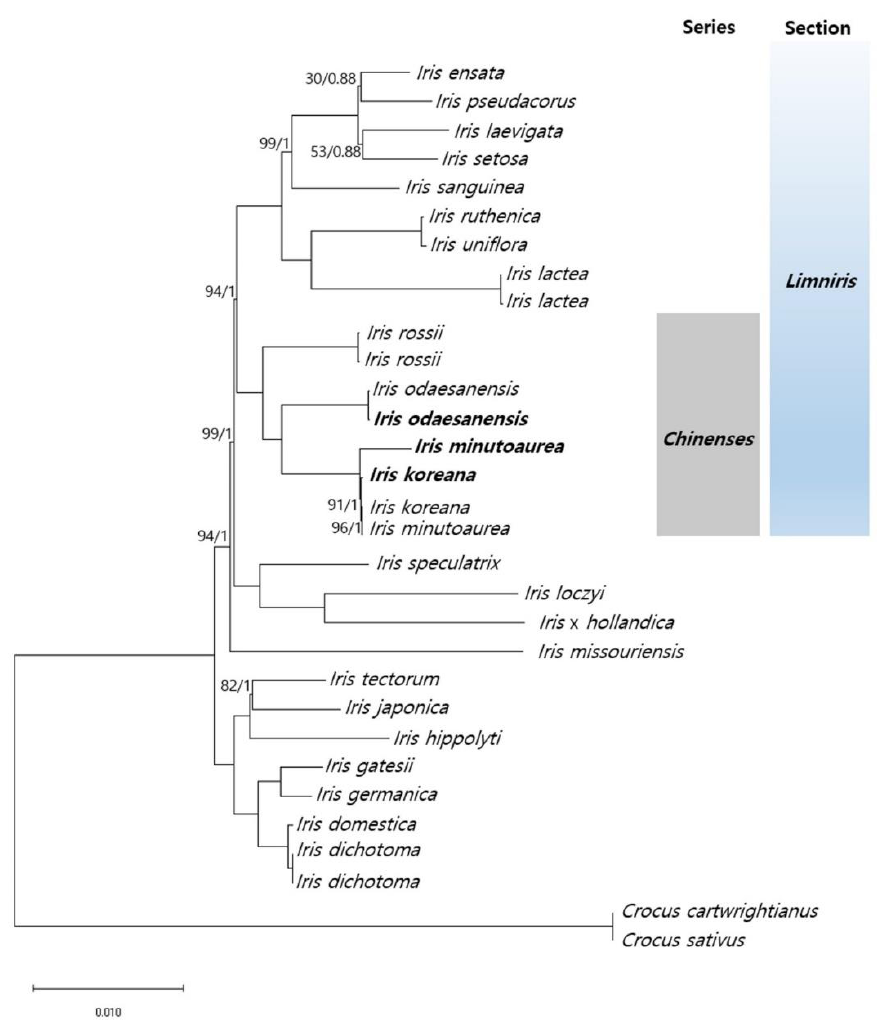
Figure 7. Phylogenic analyses of 29 Iris samples inferred from maximum likelihood (ML) and Bayesian inference (BI)-based analyses on 78 coding sequences. Branches with support of 100/1 were not indicated and maximum posterior probability (PP) are indicated above as the following (BS/PP). The newly included cp genomes by this study are indicated in